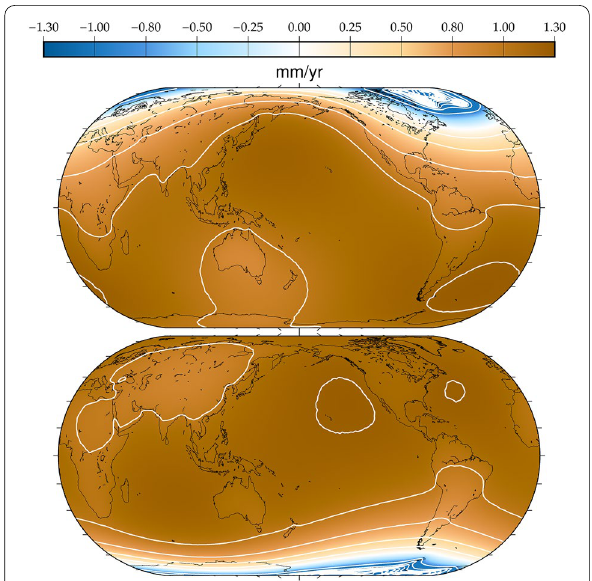
Fig. 9 Example of sea-level fingerprints for Antarctic (lower panel) and Greenland (upper panel) meltwater. Meltwater produced from each ice sheet creates a different magnitude of sea level depending on position relative to the source region. The value plotted in each panel is the dimensionless quantity (�ζ rsl (φ) − �ζ gmsl (φ))/�ζ gmsl (φ) , where Δ ζ gmsl ( φ ) is global mean sea level added to the oceans over a short (effectively instantaneous) time interval. Contours are in increments of 0.25 for positive and 1.0 for negative values. The far field signal is uniquely characteristic of the source